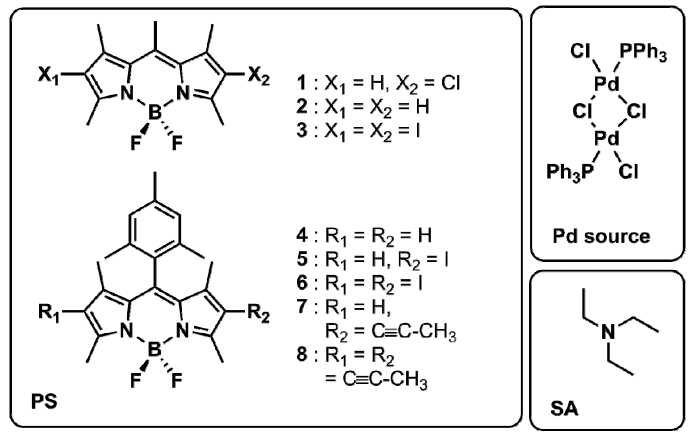
Figure 1. Components of the multicomponent catalyst systems presented.